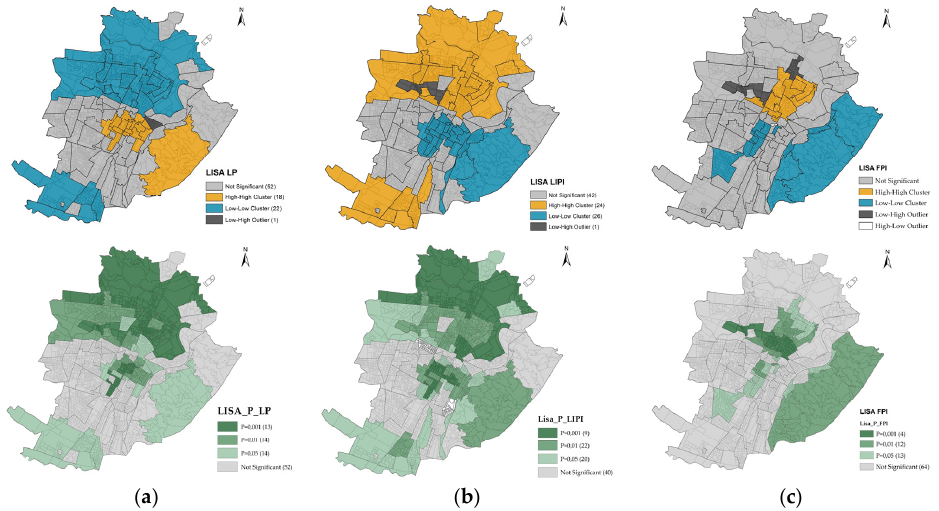
Figure 6. LISA (Cluster and Significance) maps depicting spatial clustering and spatial outliers in the 93 HTUs of Turin, 2011: ( a ) LP rate, measured in Euro per square meter; ( b ) LEPI rate; ( c ) FPI rate (Source: Authors’